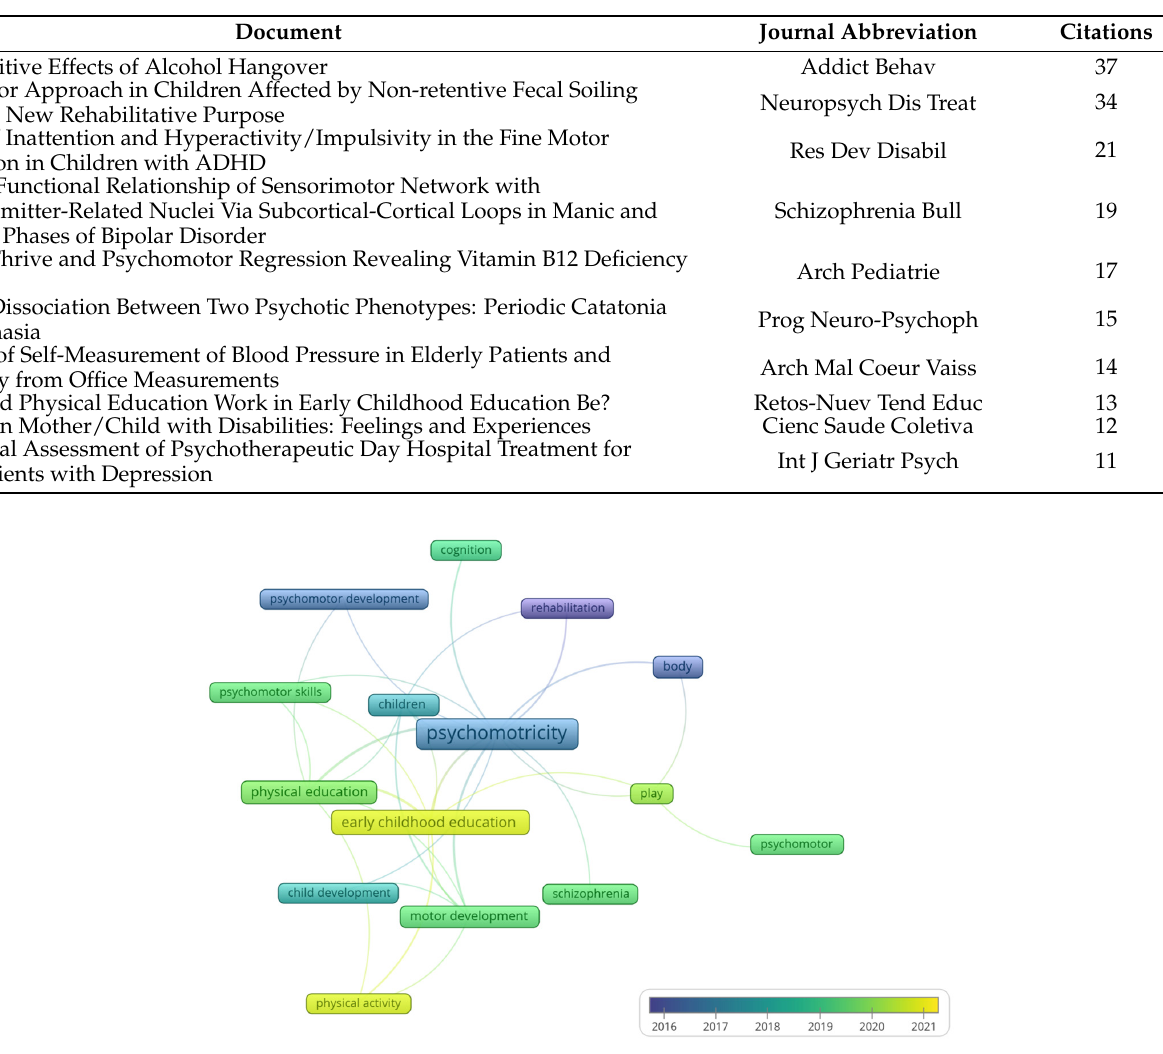
Figure 4. Most cited journals and their co-citations. Table 3. More cited documents in psychomotricity.